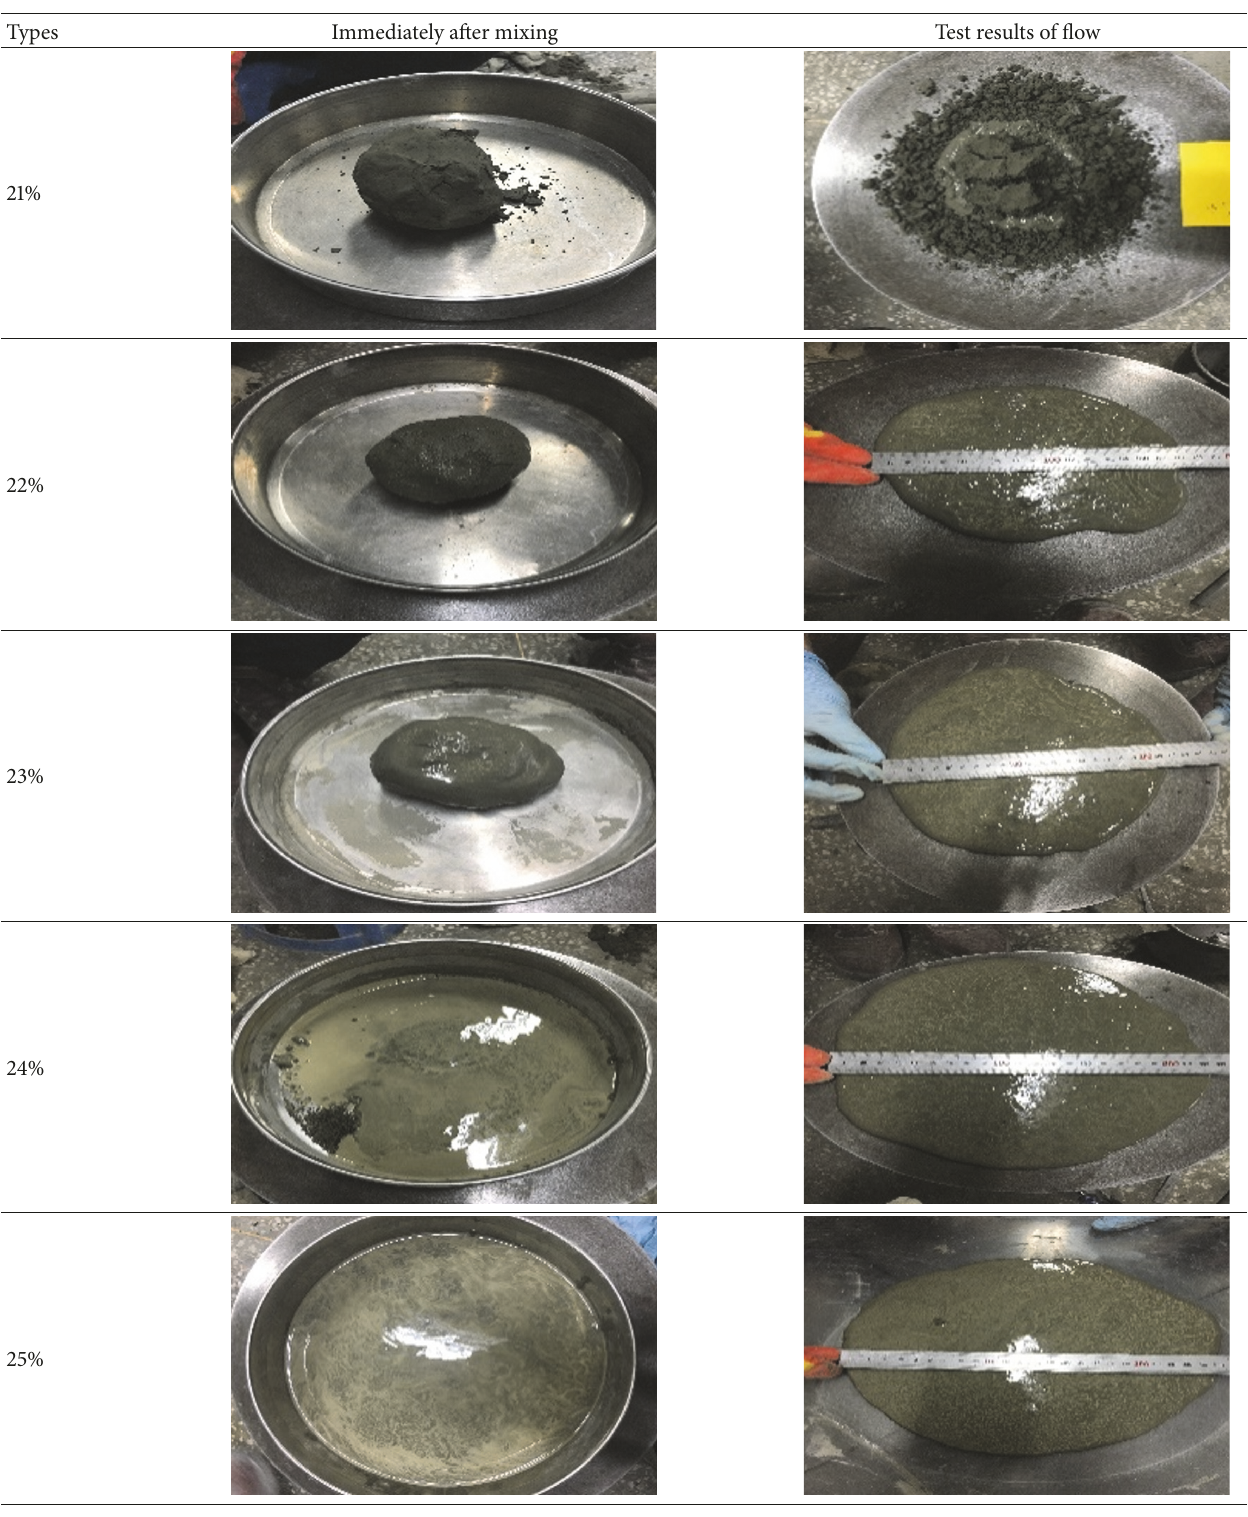
Table 3: Consistencies of Step 2 test